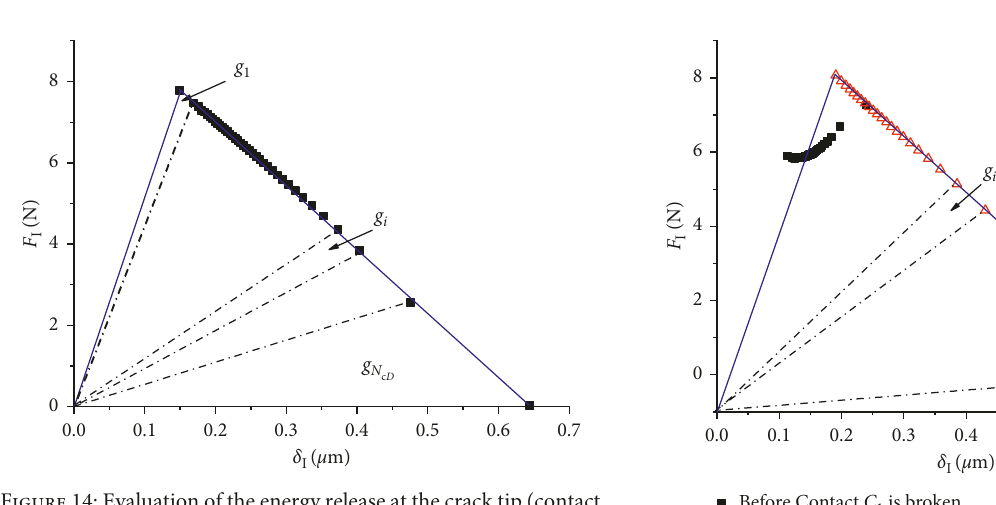
Figure 13: Principal components of force and displacement for a certain contact being (a) the first contact (defined clockwise) in a pair and (b) the second contact in a pair.